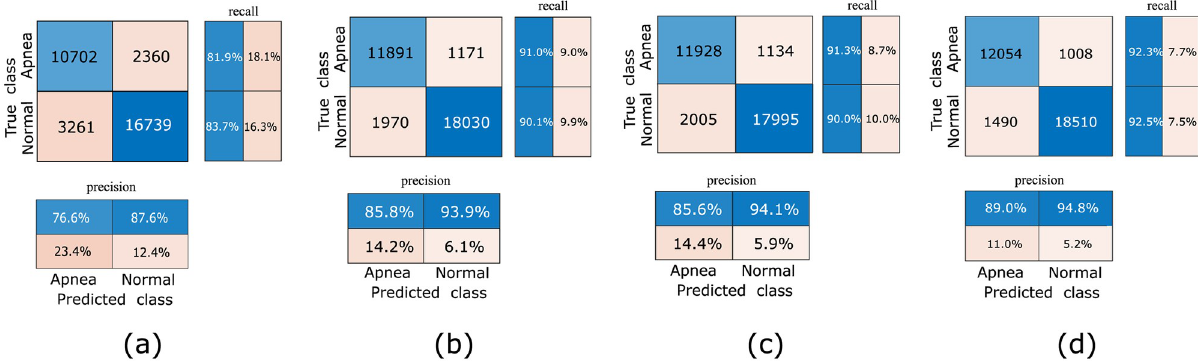
Fig 8. Confusion matrices for per-segment apnea detection, with classwise PR and RE shown in the bottom and right-hand boxes, respectively: (a) Wigner–Ville distribution images, (b) scalogram images, (c) spectrogram images, and (d) fused images.